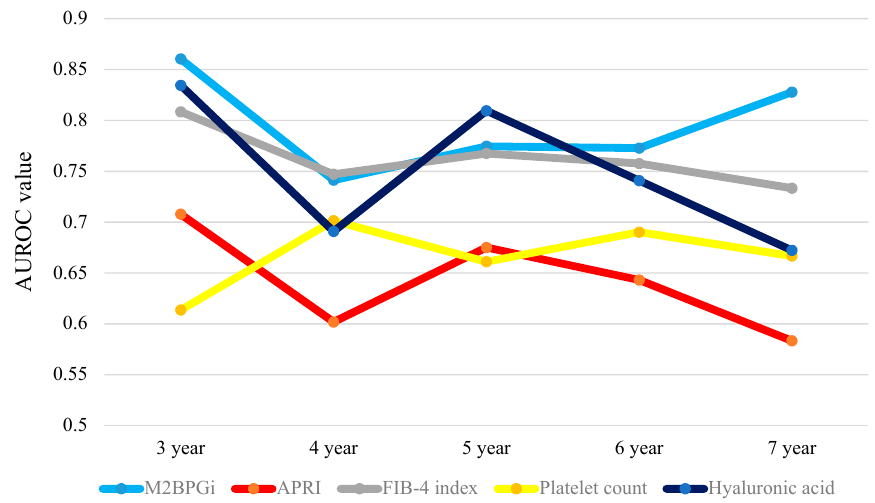
Figure 7. Time-dependent ROC analyses of five liver fibrosis markers (WFA + -M2BP, APRI, FIB-4 index, platelet count and hyaluronic acid) for OS in non-HCC cases. This figure presents the plots of annual AUROCs of five liver fibrosis markers. The TAAT score indicates total sum of AUROCs in all time-points in each liver fibrosis marker. TAAT score: WFA + -M2BP: 3.97663; APRI: 3.21116; FIB-4 index: